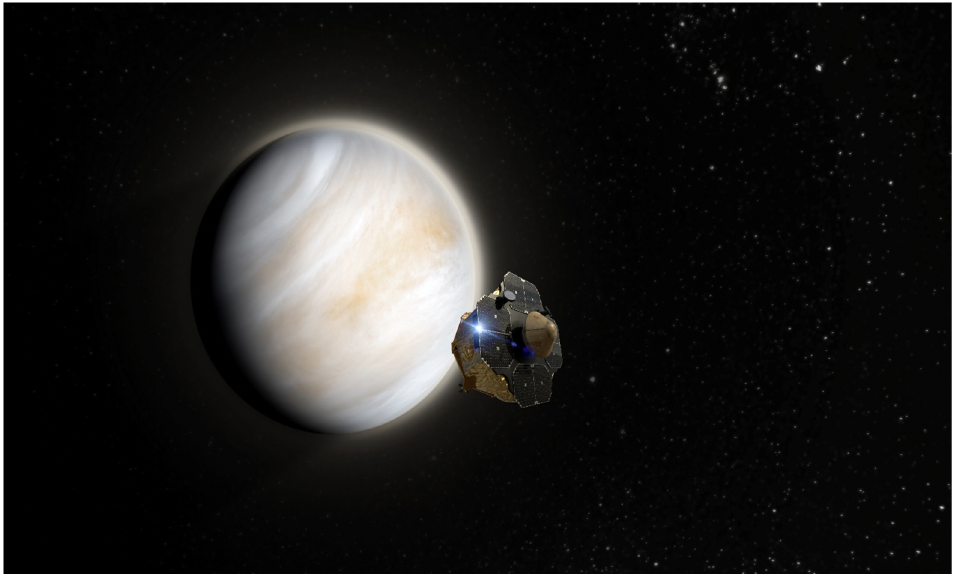
Figure 1. Rocket Lab’s Electron-launched private mission to Venus will deploy a small probe from a high-energy Photon.